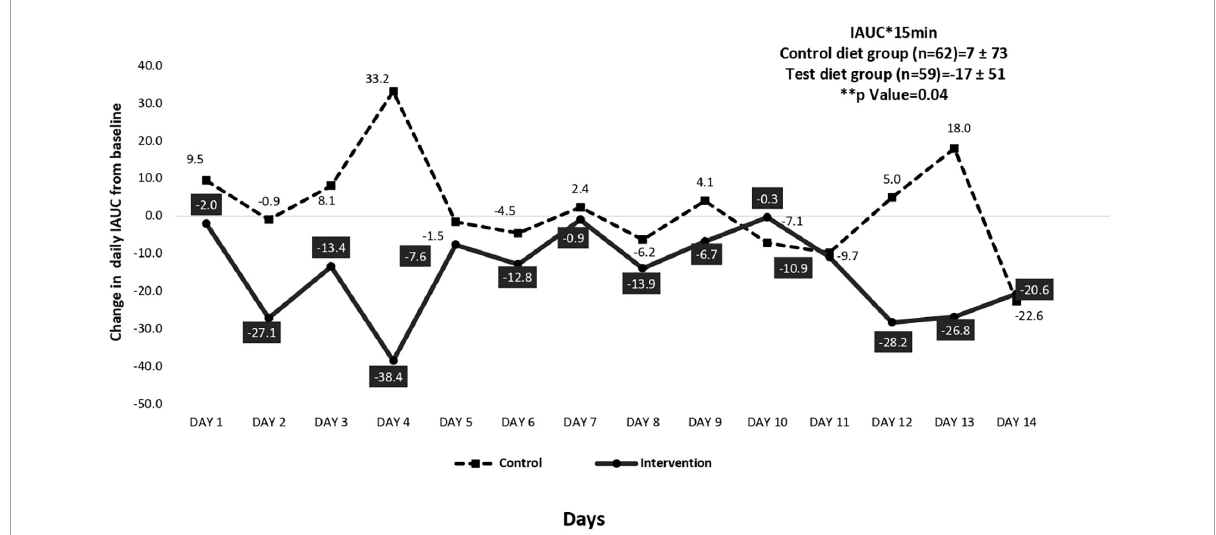
FIGURE1 Mean change in incremental area under the curve (IAUV-mg/dl) assessed by continuous glucose monitoring (CGM) system for control and intervention group participants from baseline ( n = 121).